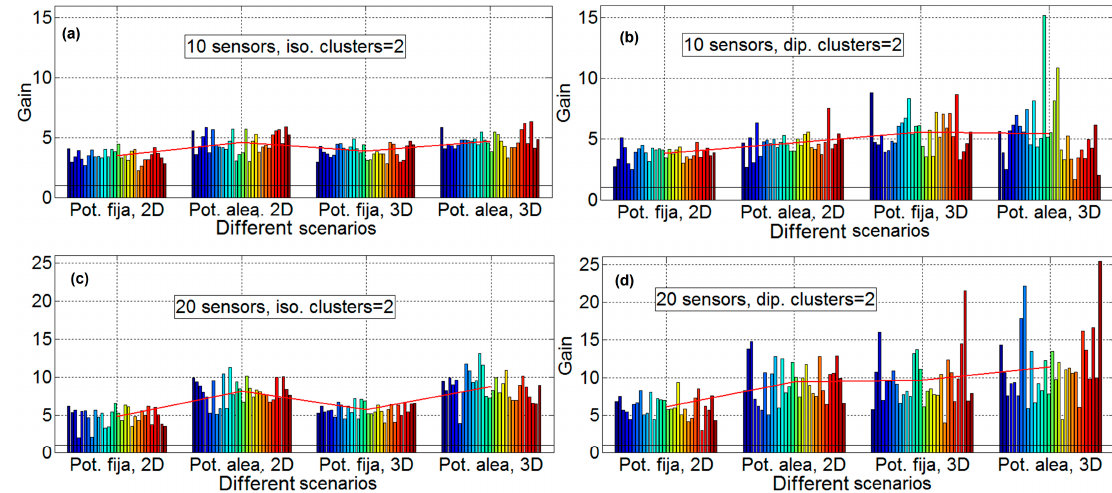
Figure 11. Gain results with two clusters, 10 and 20 sensors, all scenarios. Isotropic antenna and 10 sensors in subfigure ( a ) ( upper left ), dipole antenna and 10 Sensors in subfigure ( b ) ( upper right ), isotropic antenna and 20 sensors in subfigure ( c ) ( lower left ) and dipole antenna and 20 sensors in subfigure ( d ) ( lower right ).